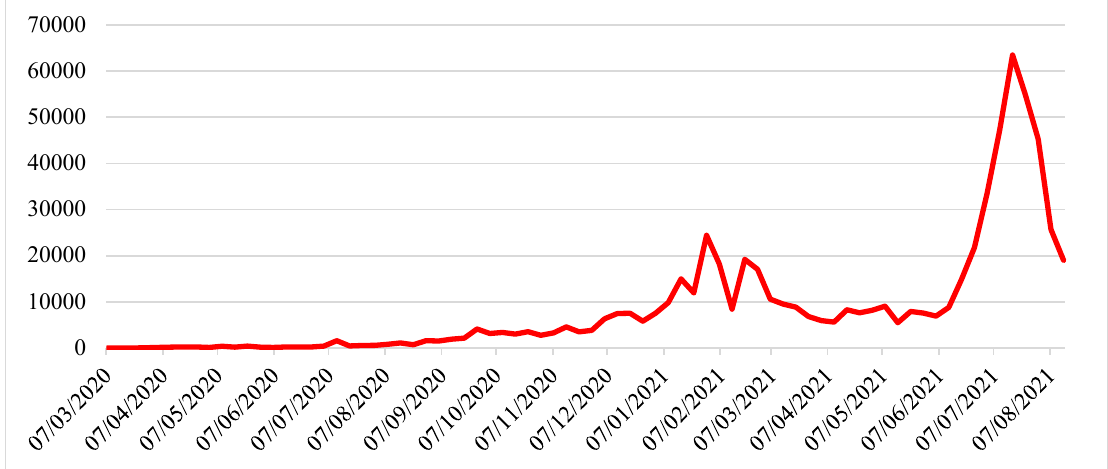
Fig. 1. The Number of Weekly COVID-19 New Case in West Java on March 2020 – August 2021 March 2nd, 2020, to July 17th, 2021, before falling until August 14th, 2021. On the basis of available data, there has